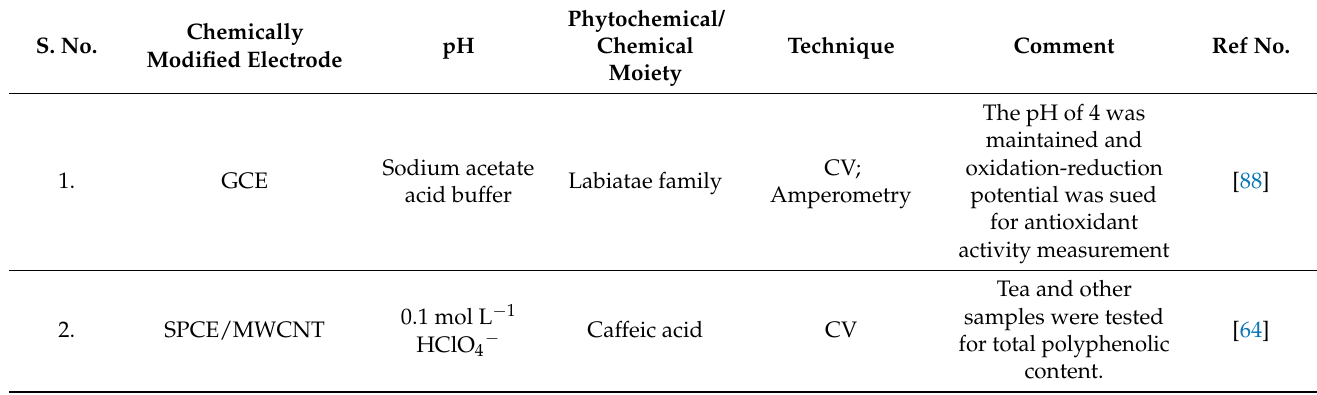
Table 5. Tabulation for the determination of Antioxidant Assay by researchers in the last two decades.